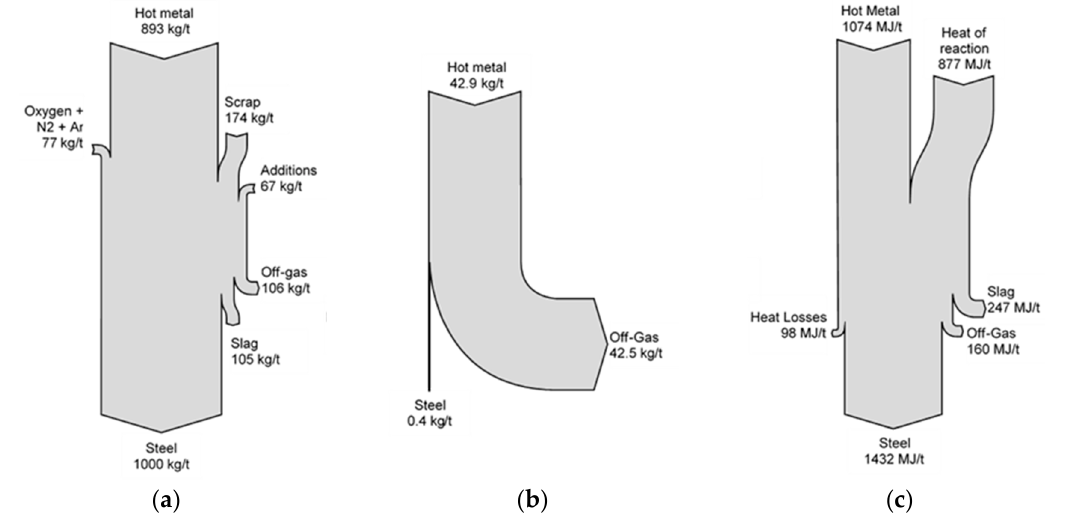
Figure 3. Sankey diagrams representing ( a ) mass, ( b ) carbon and ( c ) energy flows for a standard heat (no FeSi, no anthracite, 1250 ◦ C hot metal temperature, 1700 ◦ C steel temperature) according to [17].